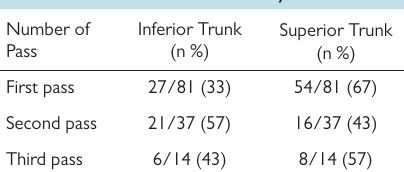
Baseline and Clinical Characteristics (n = 81) N (%)